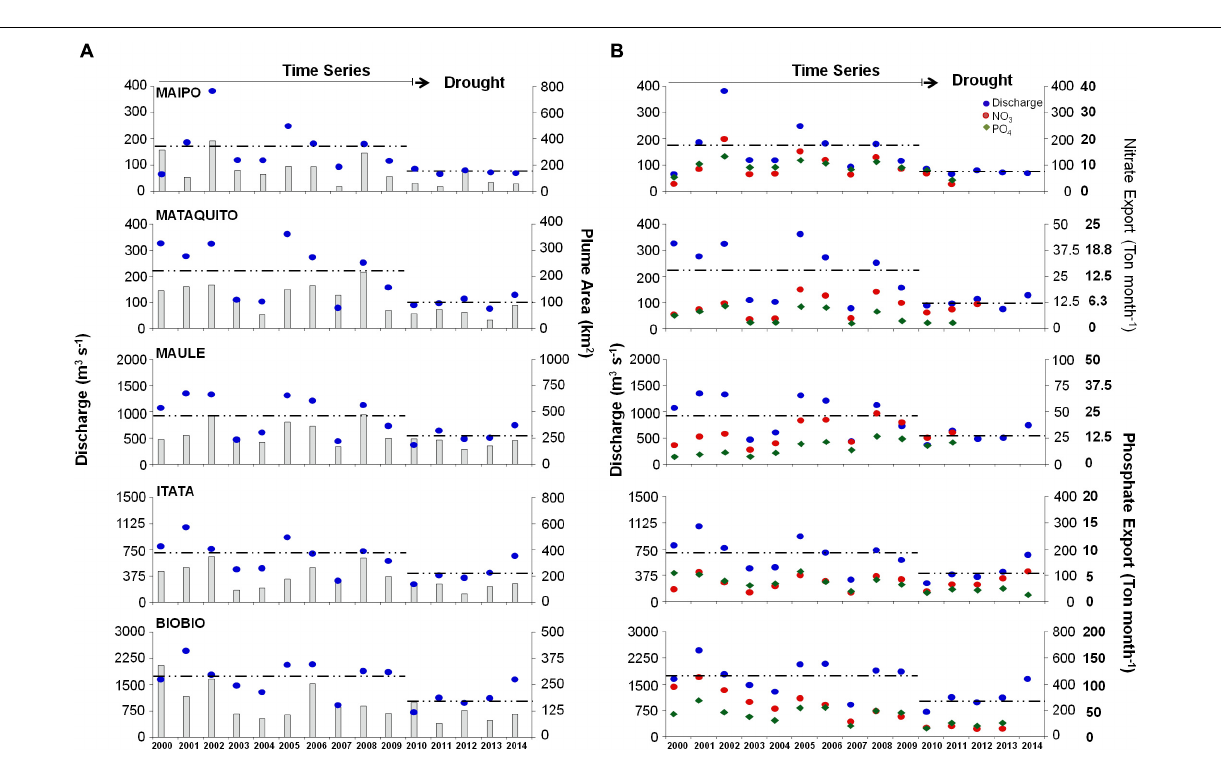
FIGURE 5 | Inter-annual variability of (A) river discharge (m 3 s − 1 ; blue circles), river plume area (km 2 ; gray bars) and (B) nitrate- NO 3 − (Ton month − 1 ; red circle) and phosphate-PO 4 − 3 export (Ton month − 1 ; green diamond). Dashed lines indicate river discharge mean value during normal (2000–09) and drought (2010–14) periods,